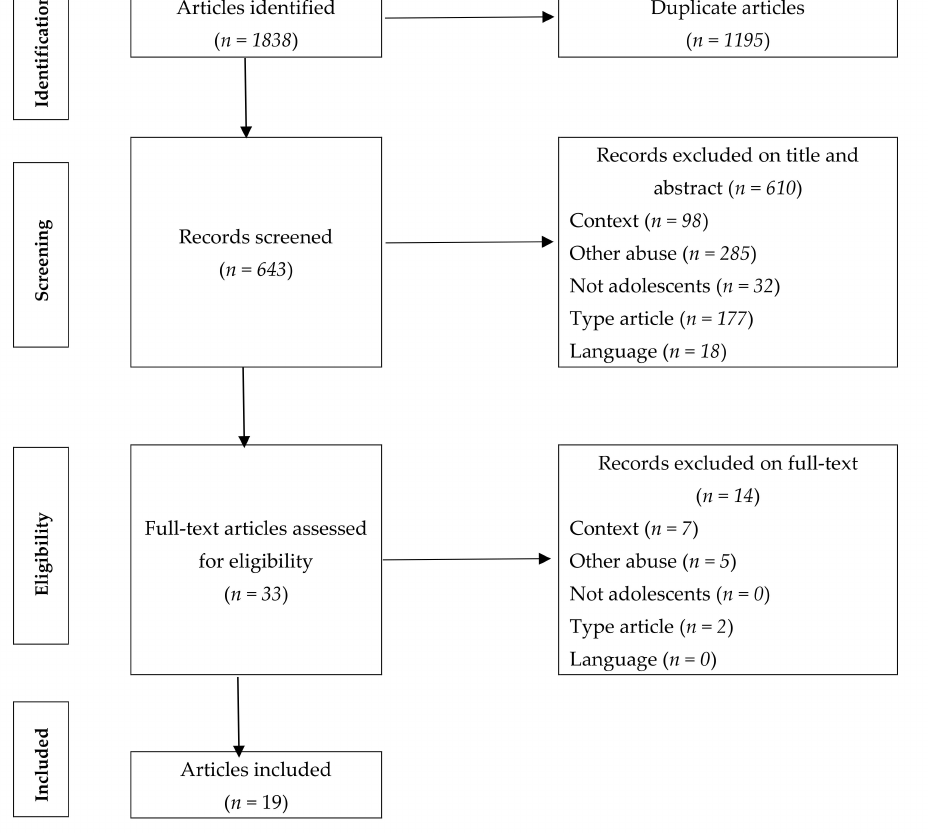
Figure 1. Flow chart of the selection process. Exclusion criteria: Context: studies investigating bullying in other contexts; Other abuse: studies investigating other forms of abuse; Not adolescents: studies not involving adolescent participants; Type article: non-quantitative studies or scientific articles; Language: study not written in English or